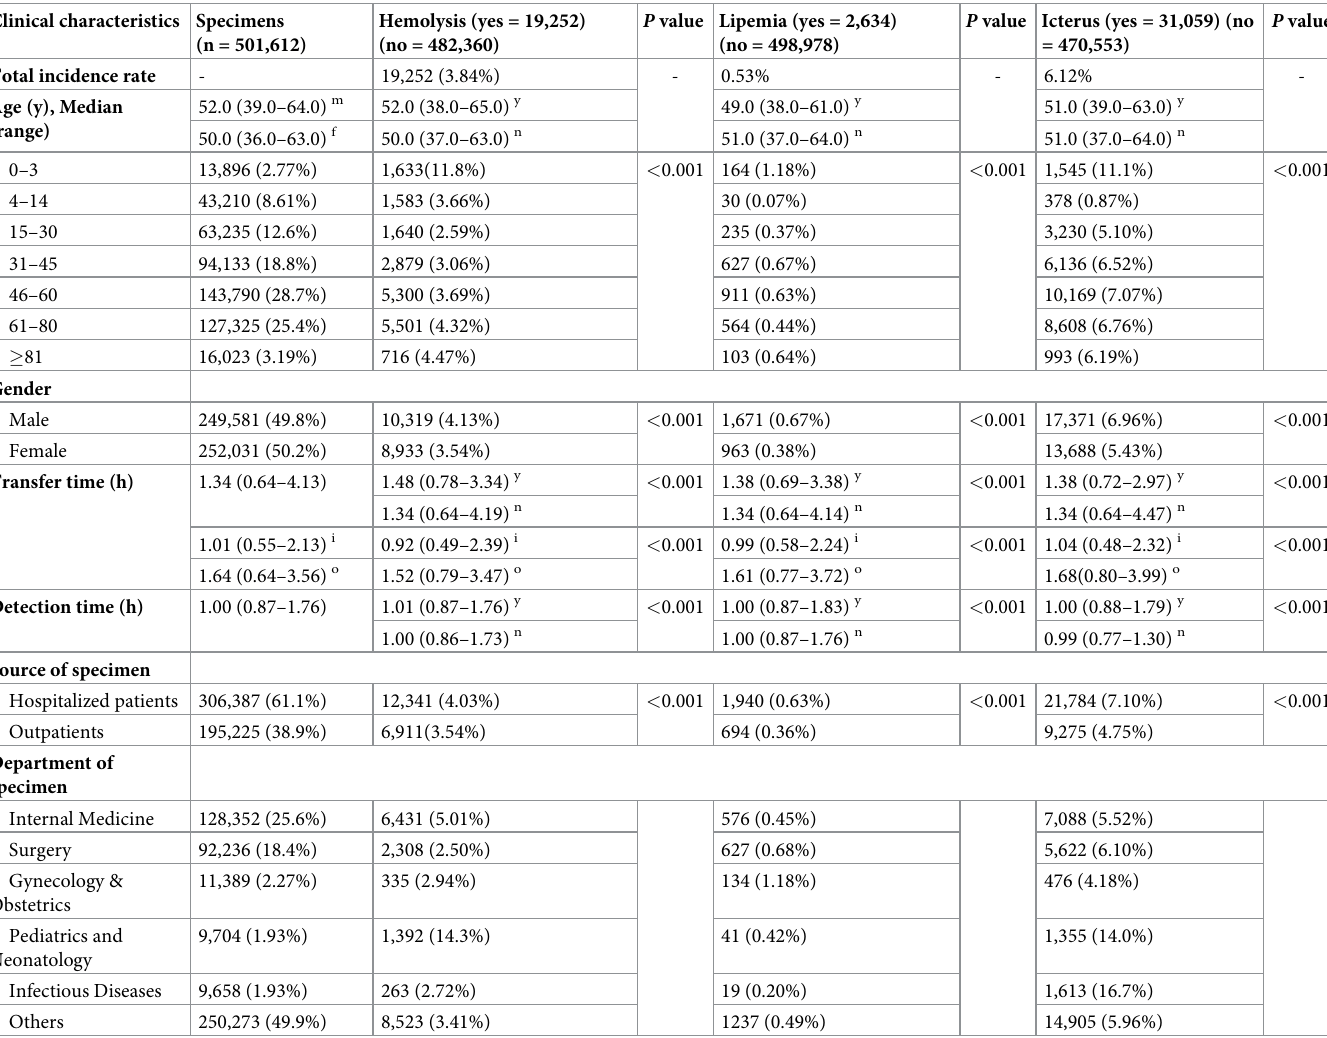
Table 1. Patients’ basic information and the incidence rate of hemolysis, lipemia, and icterus in 501,612 fasting serum biochemical specimens. Clinical characteristics Specimens (n =